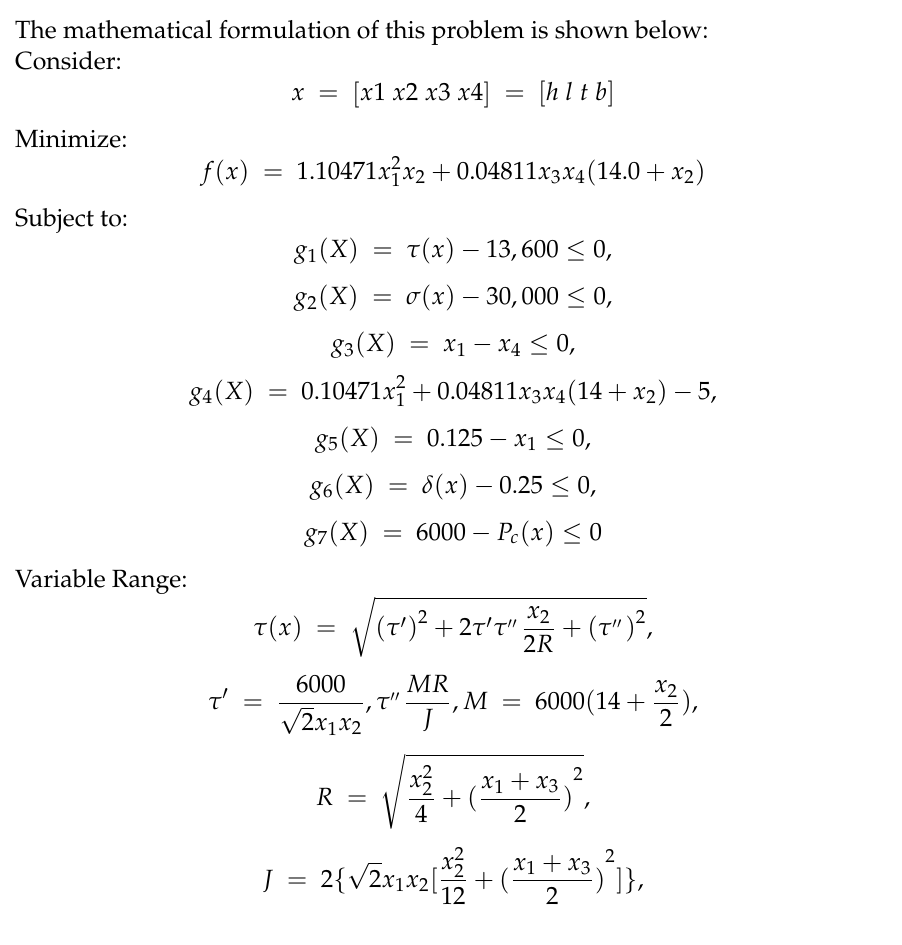
Figure 8. The welded beam